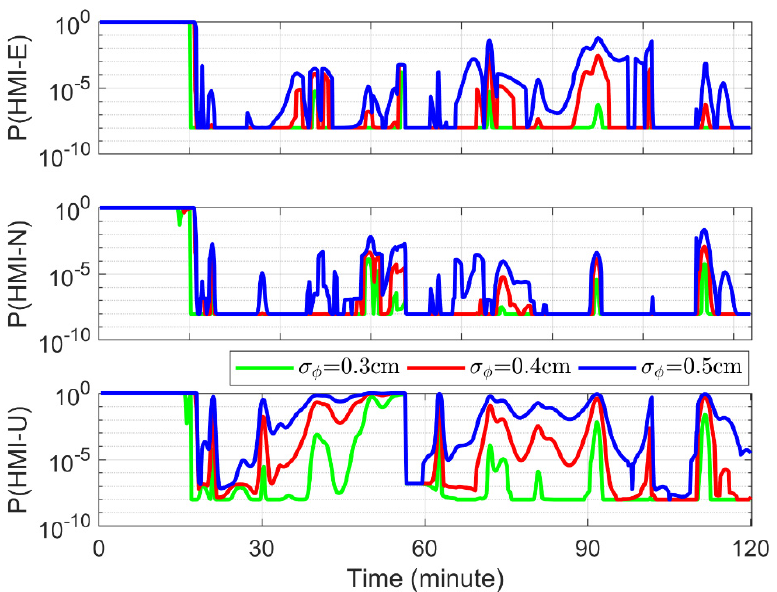
Figure 8. The integrity risk for the east (E, top ), north (N, middle ) and up (U, bottom ) directions using different STDs of raw observations. Table 3. The RMS of the PEs using different STDs of raw observations after convergence (unit: cm).